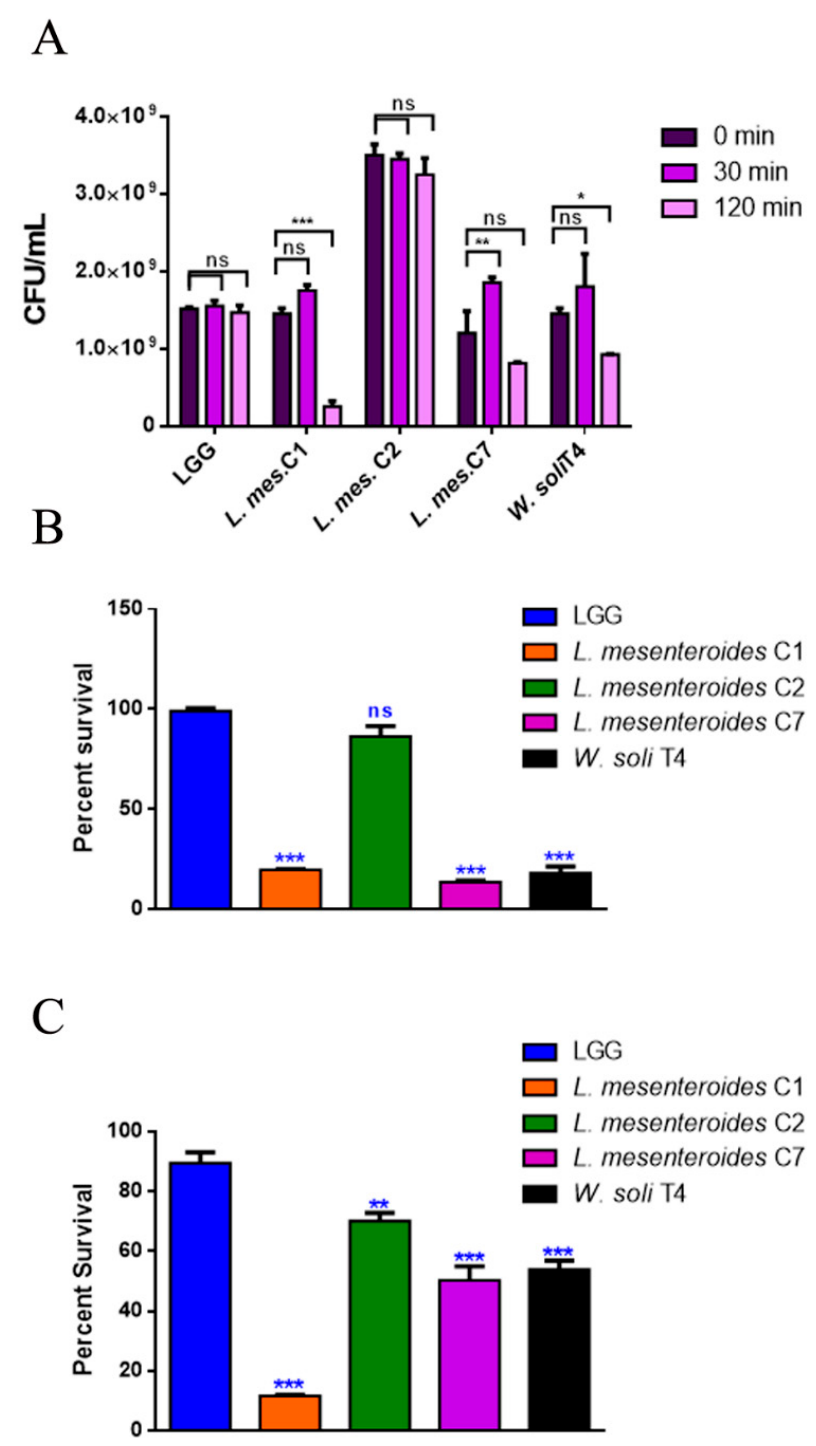
Figure 1. In vitro tolerance to lysozyme, pH 2.5 and 0.3% bile salts. ( A ) Cell counts of viable bacteria recovered at the initial time point (t0), following 30 or 120 min of incubation in 1 mg/mL of lysozyme SES buffer. ( B ) Recovery of viable bacteria after 3 h of incubation in phosphate buffer adjusted to pH 2.5 or ( C ) 0.3% bovine bile salts. LGG was taken as the LAB reference strain. Columns represent the mean ± SD of three independent experiments. Statistical analysis was performed by one-way ANOVA, followed by the Bonferroni post-test. Asterisks indicate significant differences (* p < 0.05; ** p < 0.01; *** p < 0.001), ns: not significant.